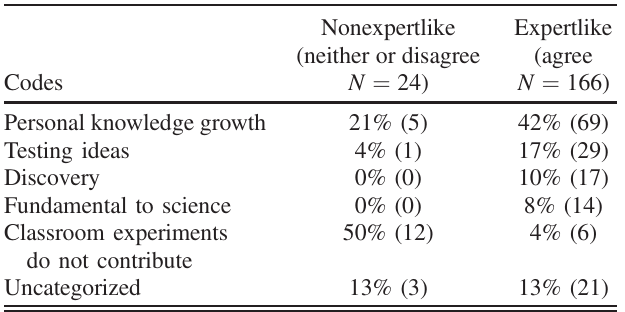
TABLE IV. Student views about Q1b “ Physics experiments contribute to the growth of scientific knowledge. ” The percent of students with expertlike or nonexpertlike Likert-scale selections whose reasoning contained particular codes. Students ’ reasoning may be coded under several codes when appropriate so percents in each column may not add up to 100%. N is the total number of students with expertlike or nonexpertlike views and the number of students with each code is given in parentheses. Codes with total frequency less than 10 (around 5% of the total population) are not